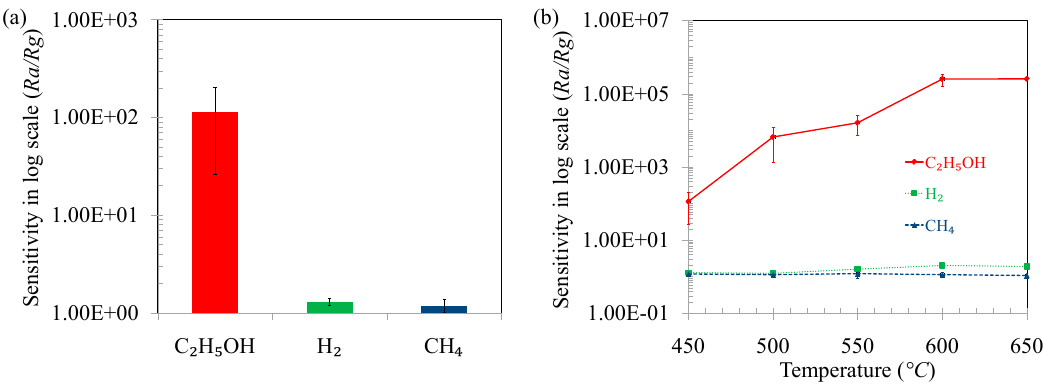
Figure 5. Response towards C 450 °C and ( b ) among ethanol, hydrogen and methane